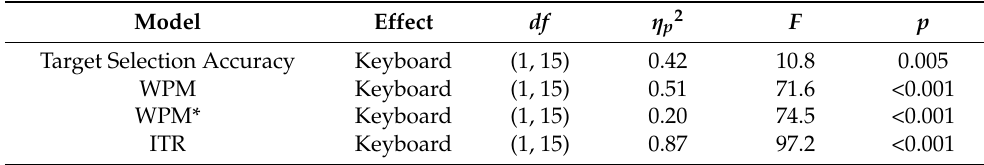
Table 2. Linear mixed-effects models for outcome measures comparing personalized and QWERTY keyboards. Model